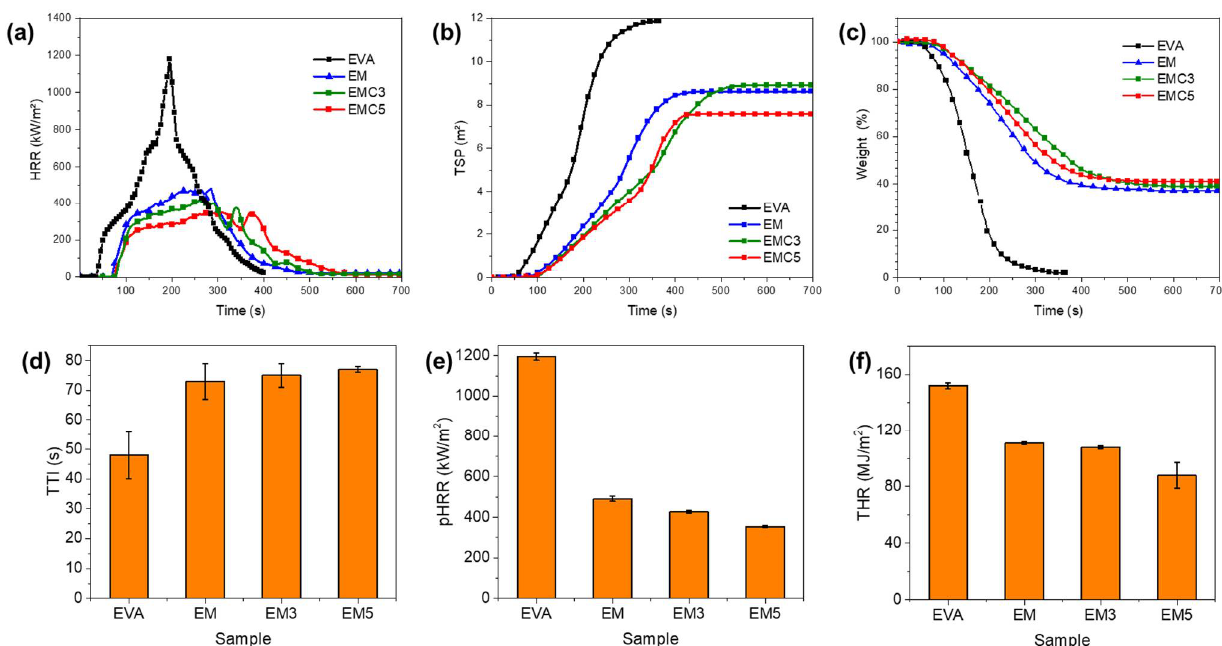
Figure 5. ( a ) HRR curves, ( b ) TSP curves, ( c ) char residue curves, ( d ) TTI, ( e ) pHRR and ( f ) THR of the pure EVA, EM, EMC3, and EMC5 composites.